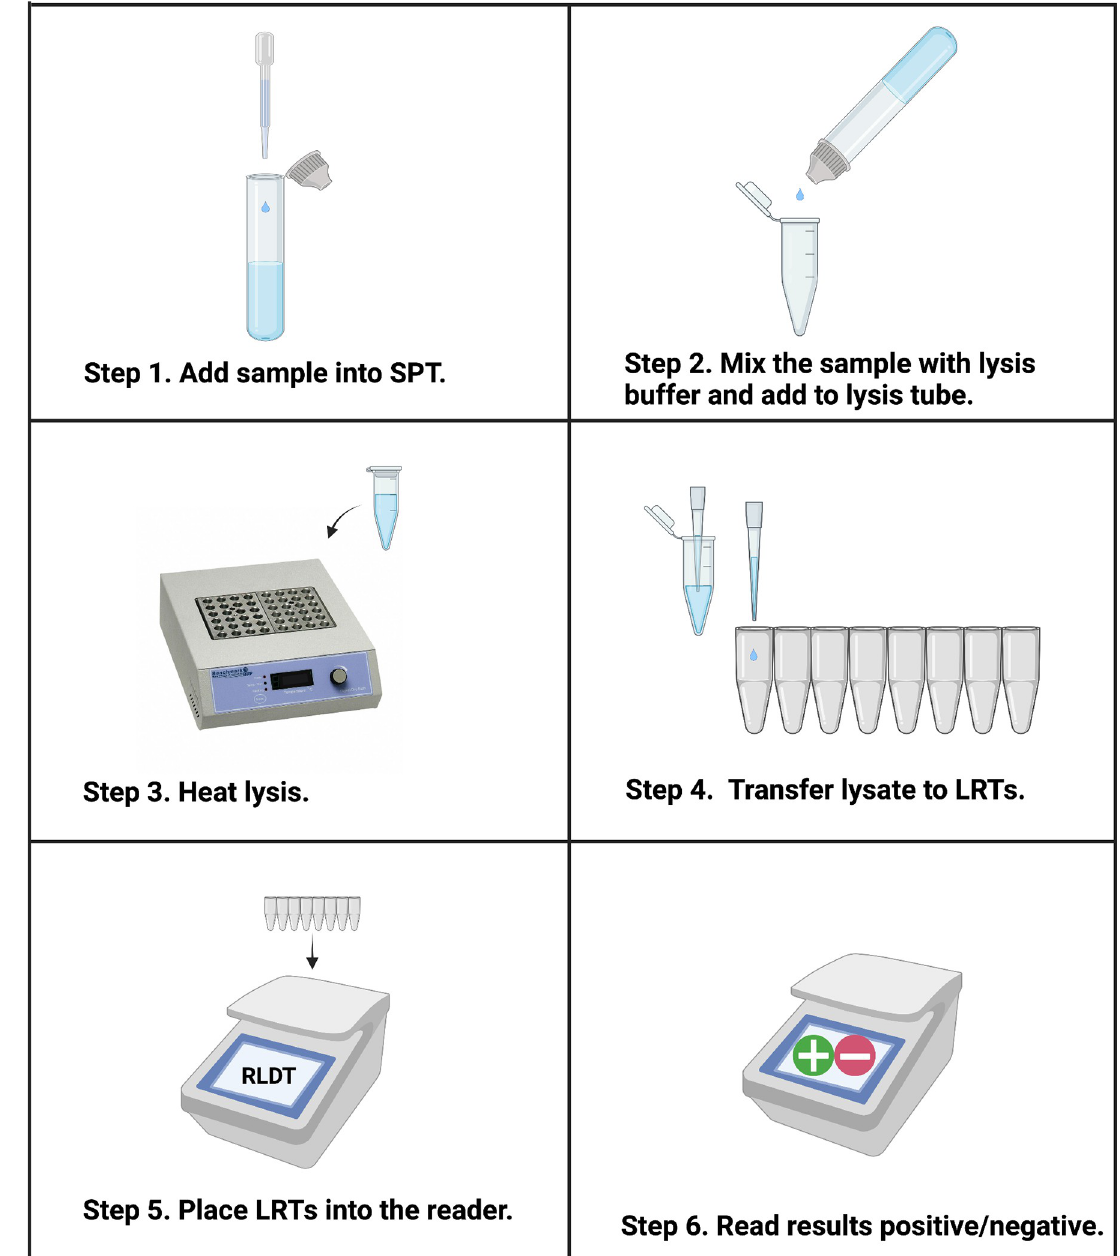
Fig 1. Workflow of cholera RLDT using RLDT kit. Step 1, using the fixed volume pipette provided in the kit, add a stool sample to the Sample Processing Tube (SPT) with lysis buffer. Step 2, Cap the SPT tube and mix by inverting the tube up and down. Squeeze the SPT tube to add the lysis buffer + stool sample to the lysis tube. Step 3, lysis tube is heated for 5 minutes in a heat block or water bath. Step 4, add 25 μ L of lysate to each lyophilized reaction tube (LRT) strip tube using a disposable fixed volume pipette. Step 5, place the LRTs in the reader. Scan the barcode for the cholera RLDT program. Step 6, read the results displayed on the screen real time or after 40 minutes. All the reagents and sample processing accessories required for RLDT are included in the kit. The illustration was created with BioRender. com https:doi.org/10.1371/journal.pntd.0010180.g001.